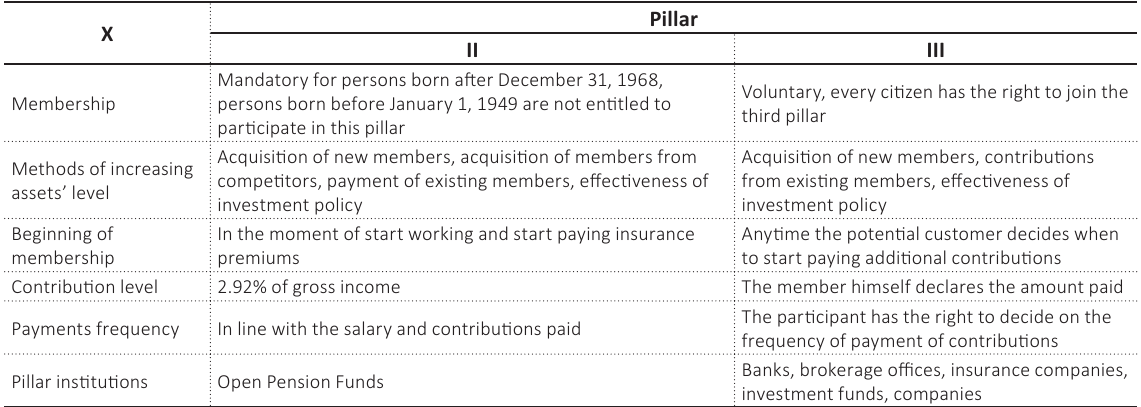
Table 2. Characteristics of supplying capital pension pillars in Poland – state before the closure